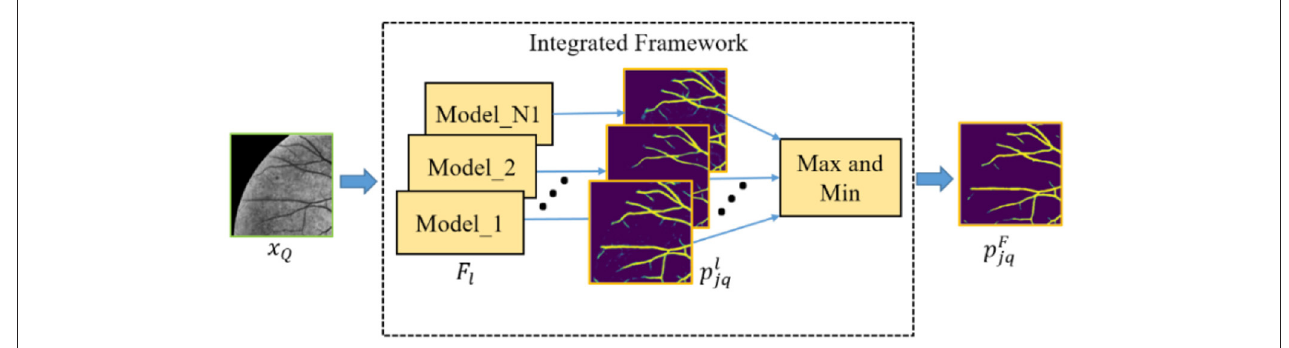
FIGURE 4 | An overview of the integrated framework.